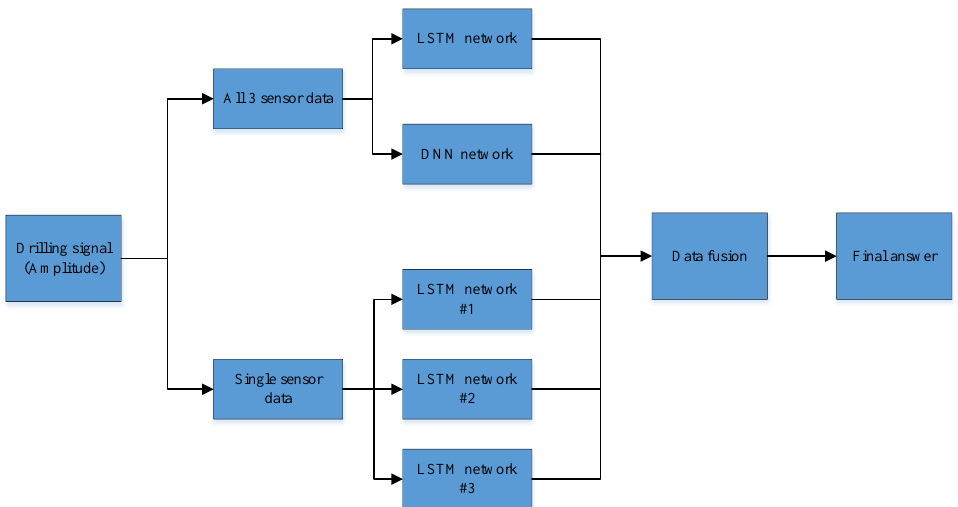
Figure 8. The architecture of the proposed identification neural network model.